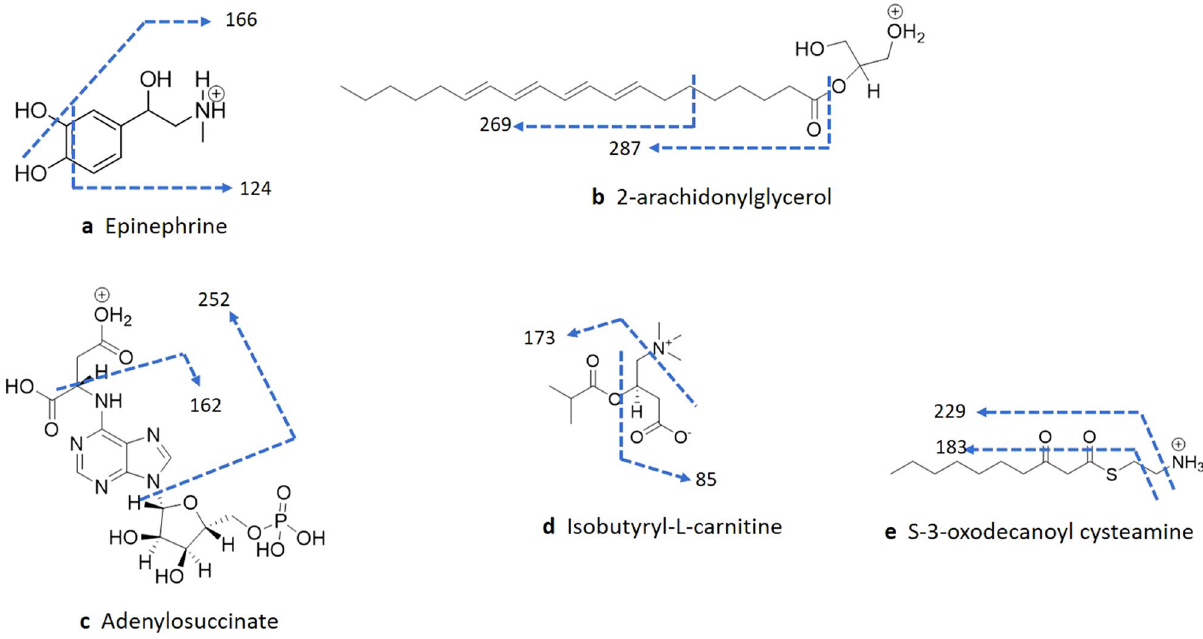
Figure 4. MS n fragmentation confirm the identity of compounds differentially expressed in the brainstem and cerebral cortex regions of the